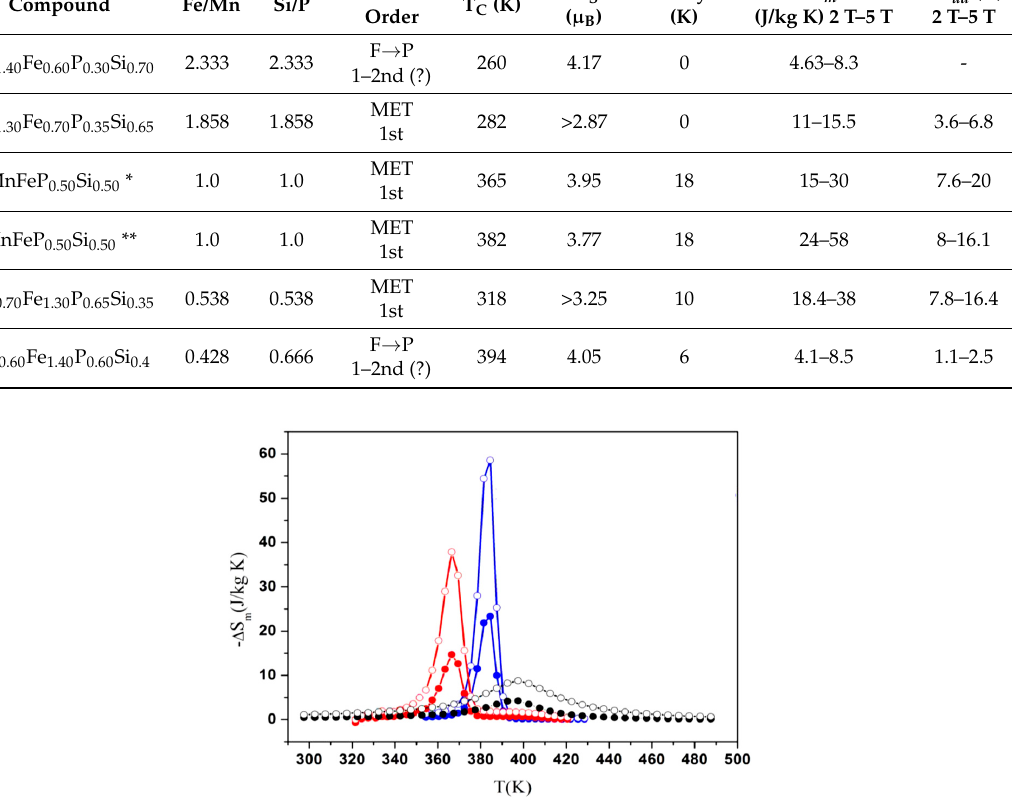
Figure 11. The Δ S m variations of three MnFeP 0.50 Si 0.50 samples: black dots for atomized powder [35], red dots for Fe-P + Mn-Si precursors only (*), and blue dots for atomized powders + complementary precursors (**) [36], dots are for [0–2 T] and circles are for [0–5 T] magnetic shifts, respectively.